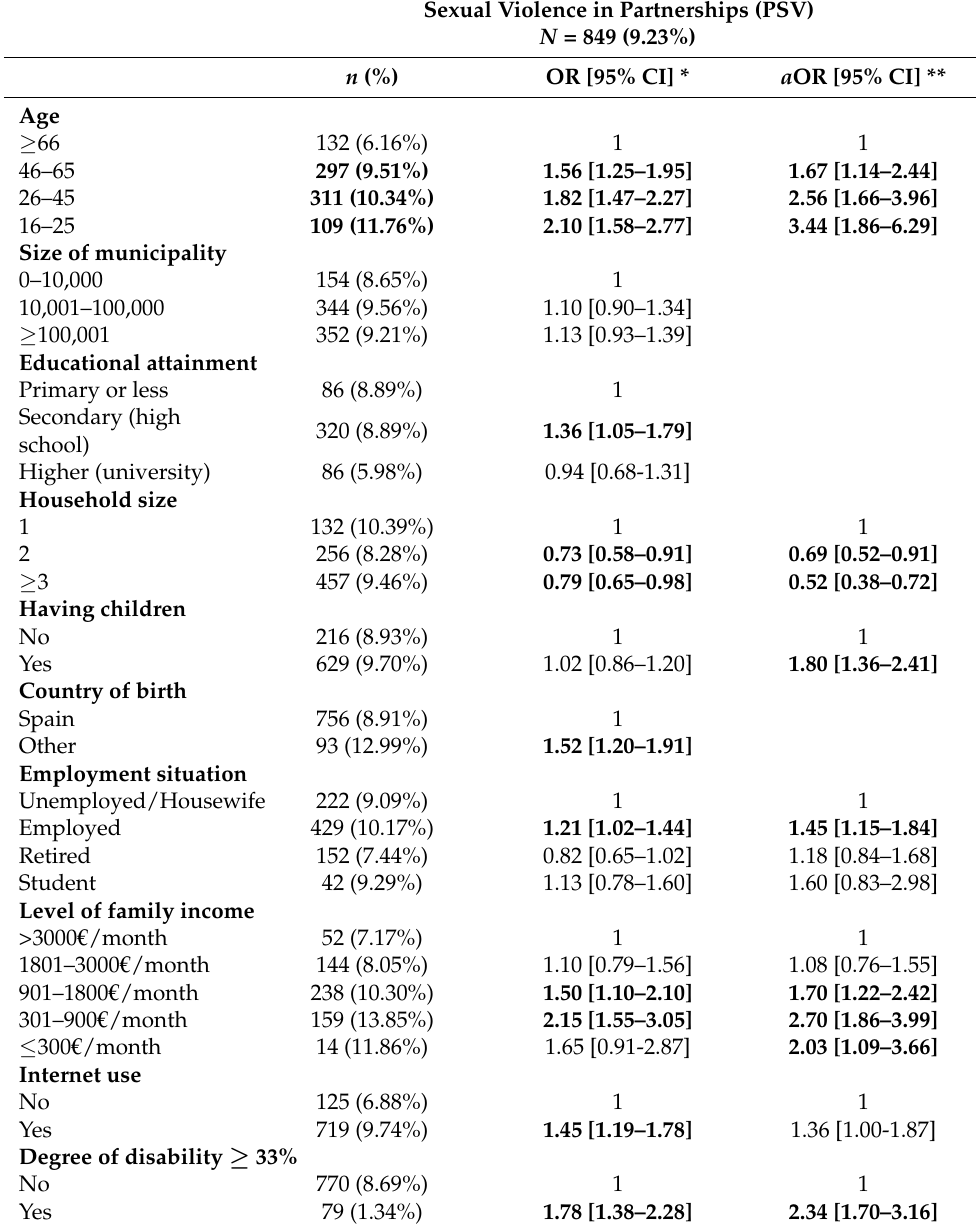
Table 1. Association between sociodemographic characteristics and